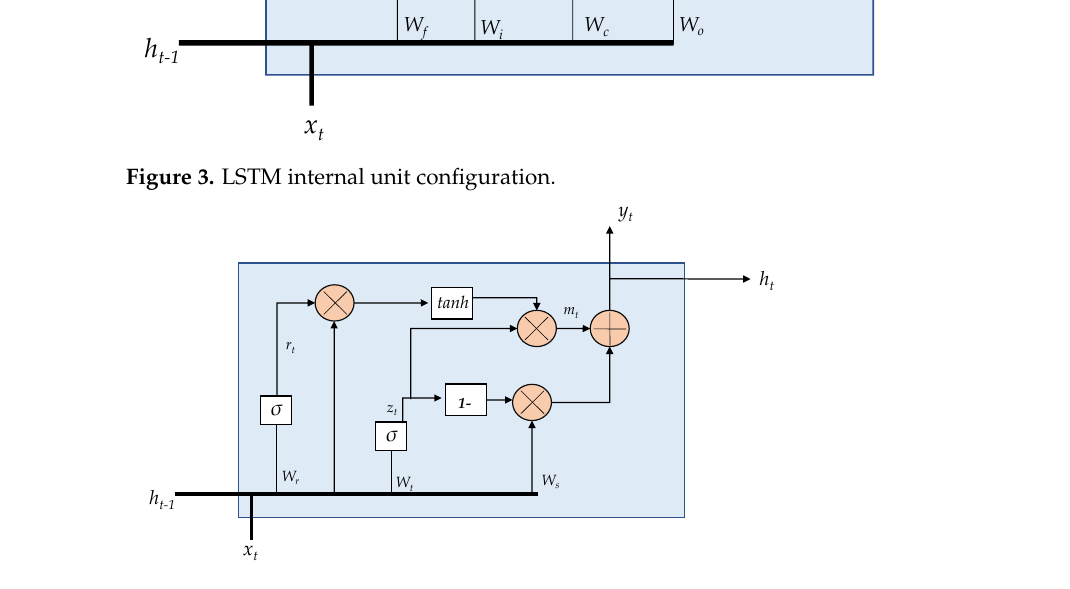
Figure 4. GRU internal unit